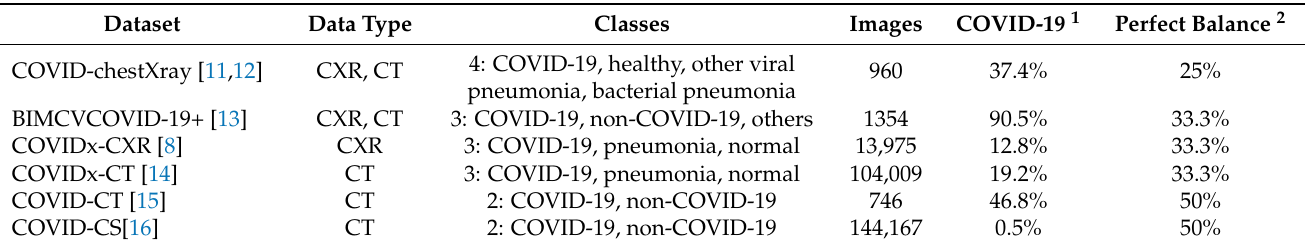
Table 1. Dataset summary. 1 Percentage of COVID-19 positive images. 2 Calculated from the number of classes in the dataset.